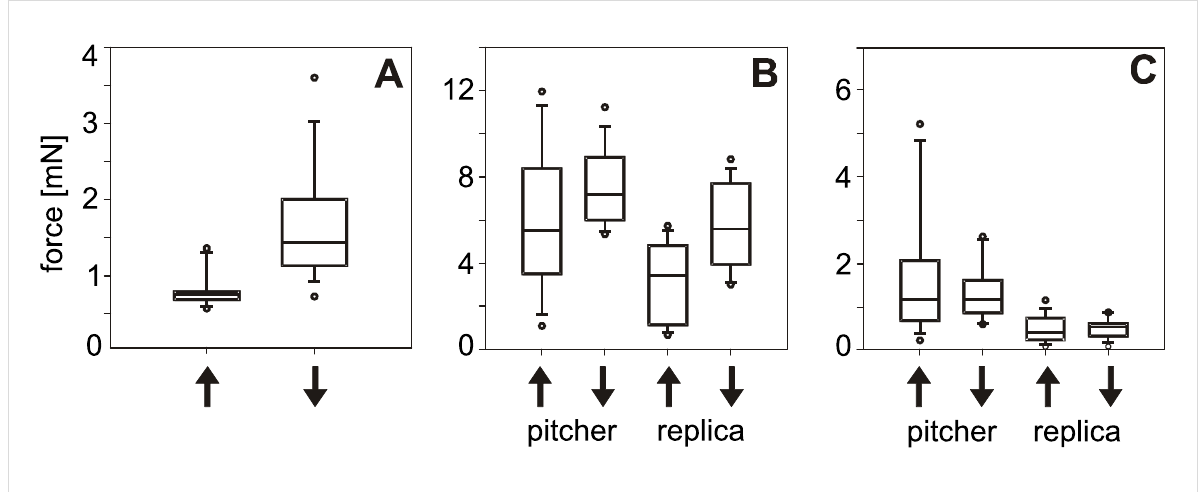
Figure 4: Results of traction force tests with Coccinella septempunctata beetles on different surfaces. (A) Experiments with both pitchers and insects intact. (B) Experiments with intact insects on de-waxed pitchers and their replicas. (C) Experiments with clawless insects on de-waxed pitchers and their replicas. Arrows pointing up indicate movement toward the pitcher peristome; arrows pointing down indicate movement towards the pitcher bottom.